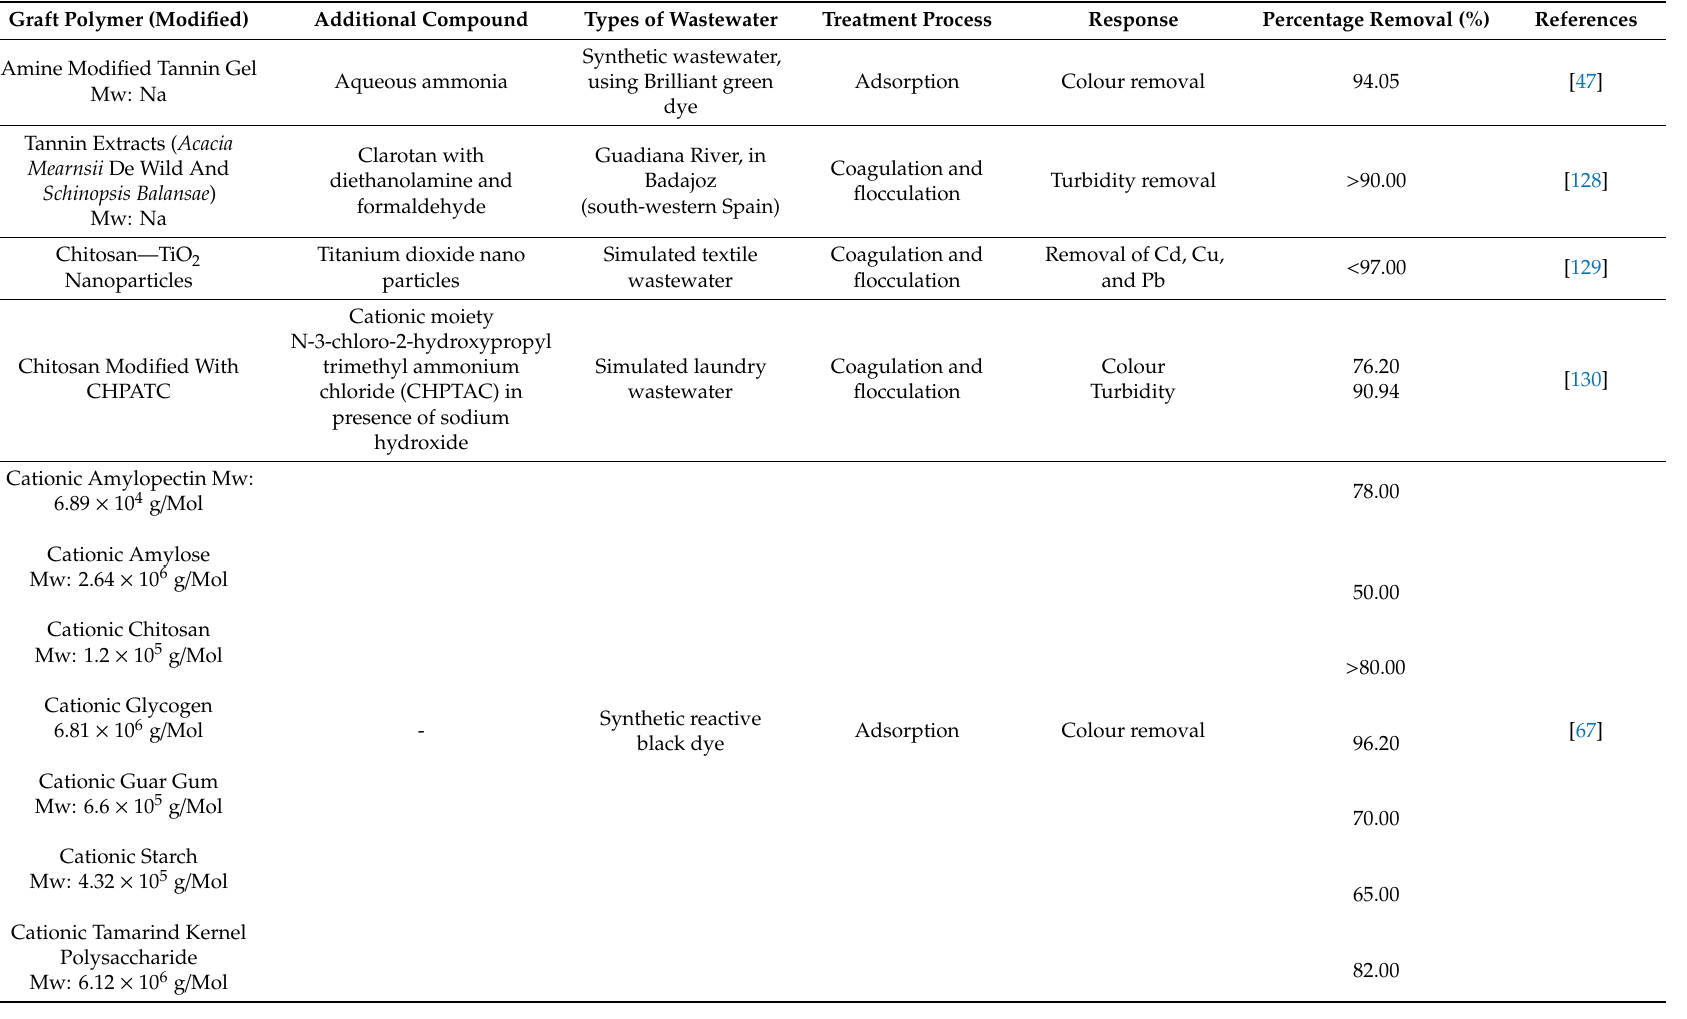
Table 8. Compilation of toxicant removal from several types of wastewater using modified